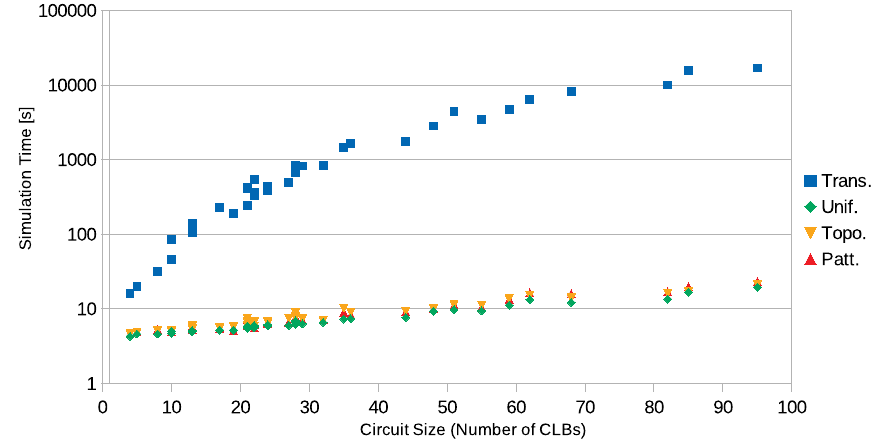
Figure 7. Simulation time of the SEV estimation processes. It presents the simulation time for the four SEV estimations as a functions of the circuit